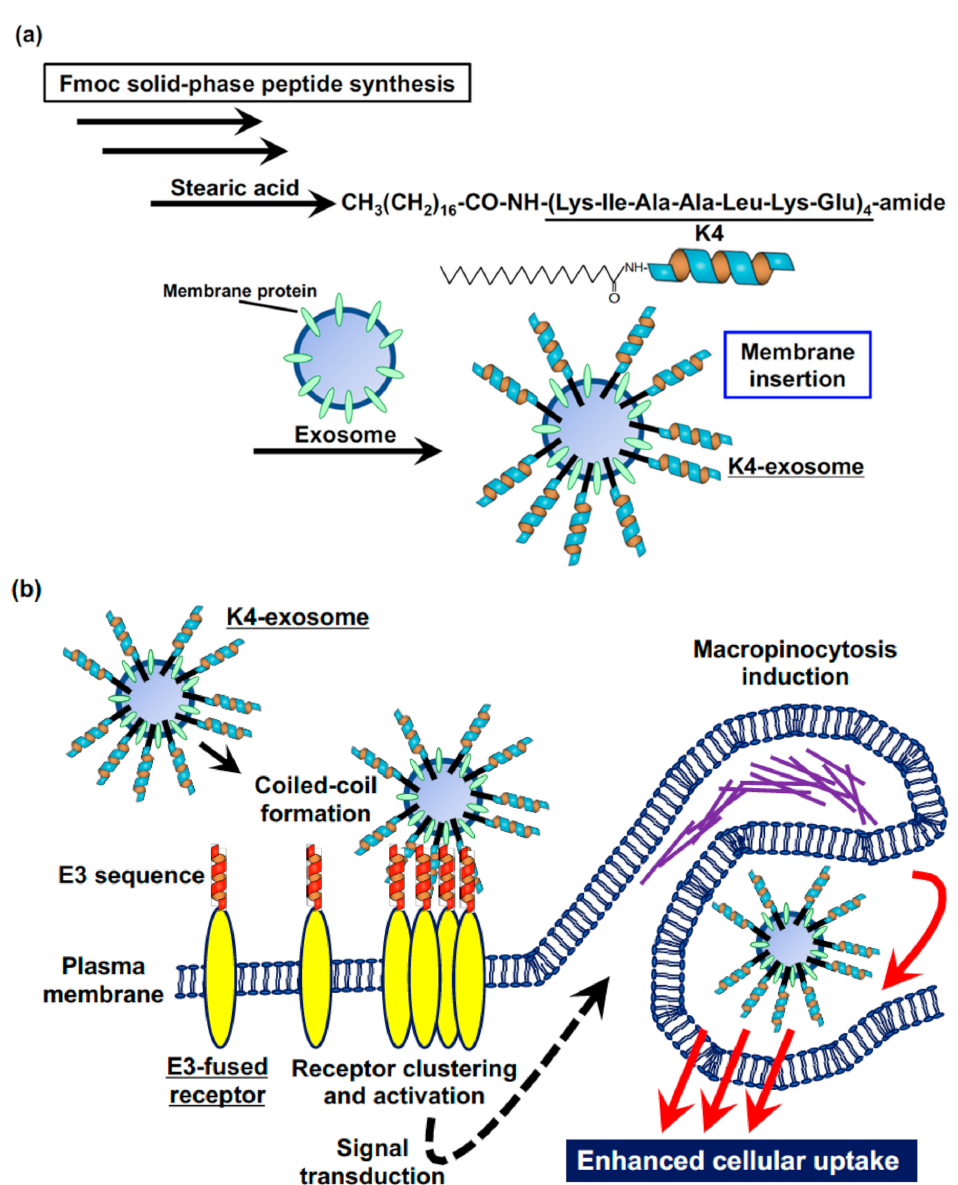
Figure 3. ( a , b ) Coiled-coil peptide-modified exosomes for recognition of tagged receptors, clustering, receptor activation, and cellular uptake via macropinocytosis. ( a ) Synthesis of stearyl-K4 peptide. ( b ) K4-exosomes recognize E3-receptors, leading to the receptor clustering, activation, signal transduction, macropinocytosis induction, and enhanced cellular uptake of the